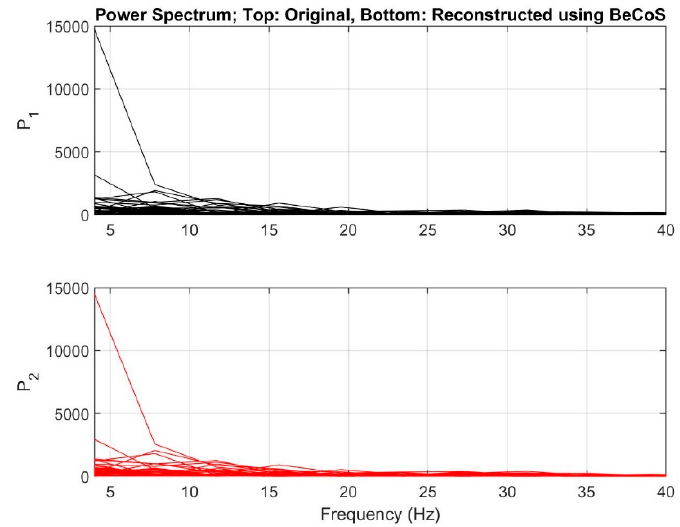
Figure 8. Power spectral density for original and reconstructed signals.